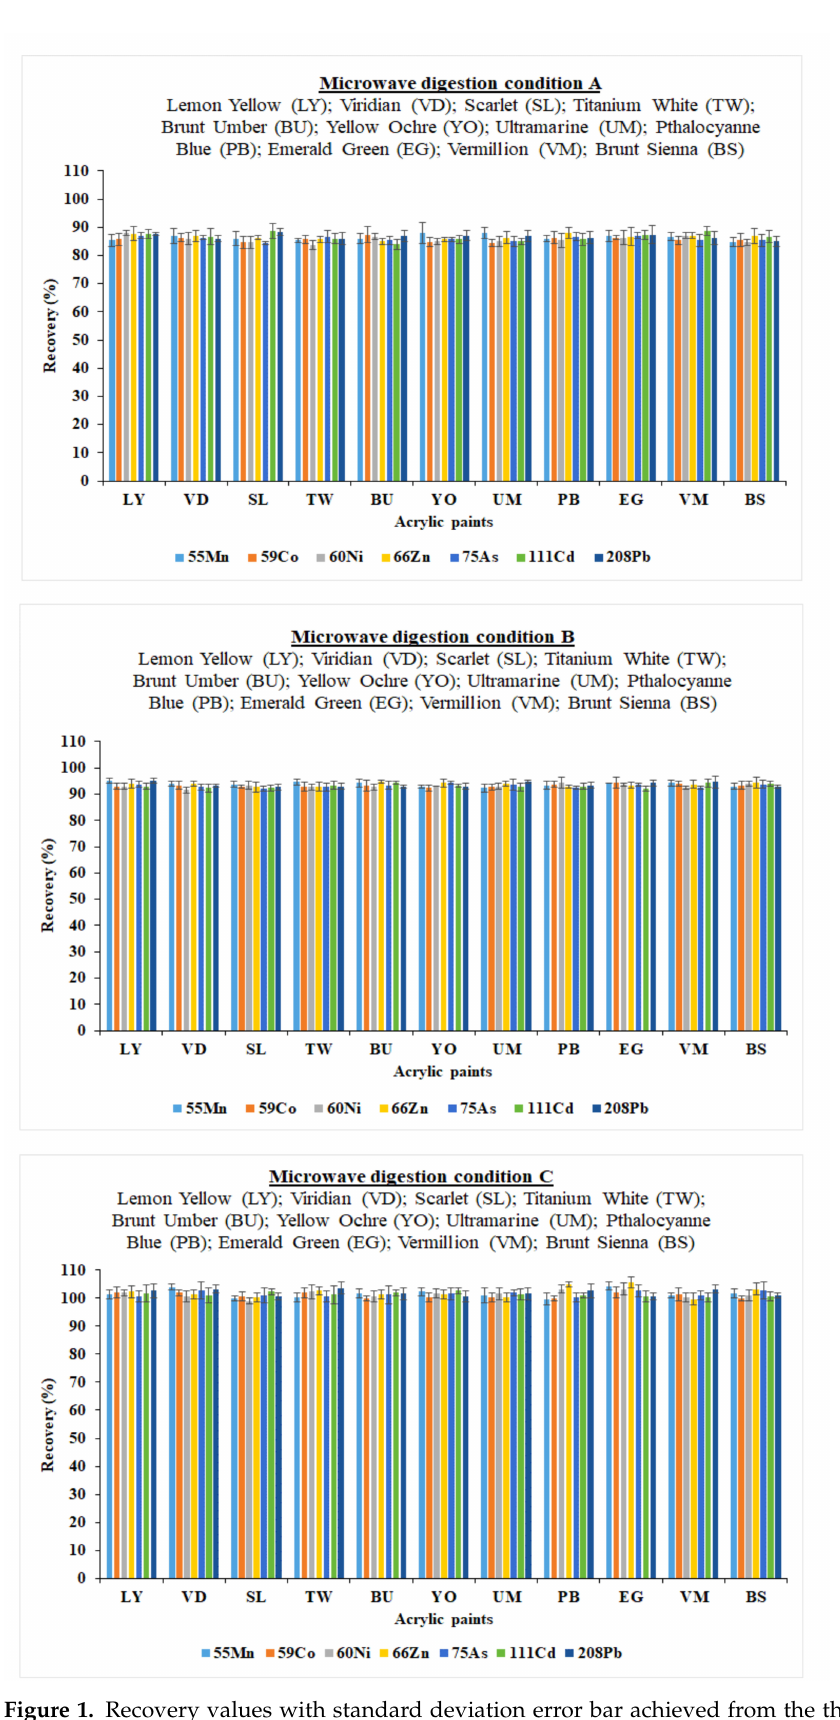
Figure 1. Recovery values with standard deviation error bar achieved from the three optimized microwave digestion